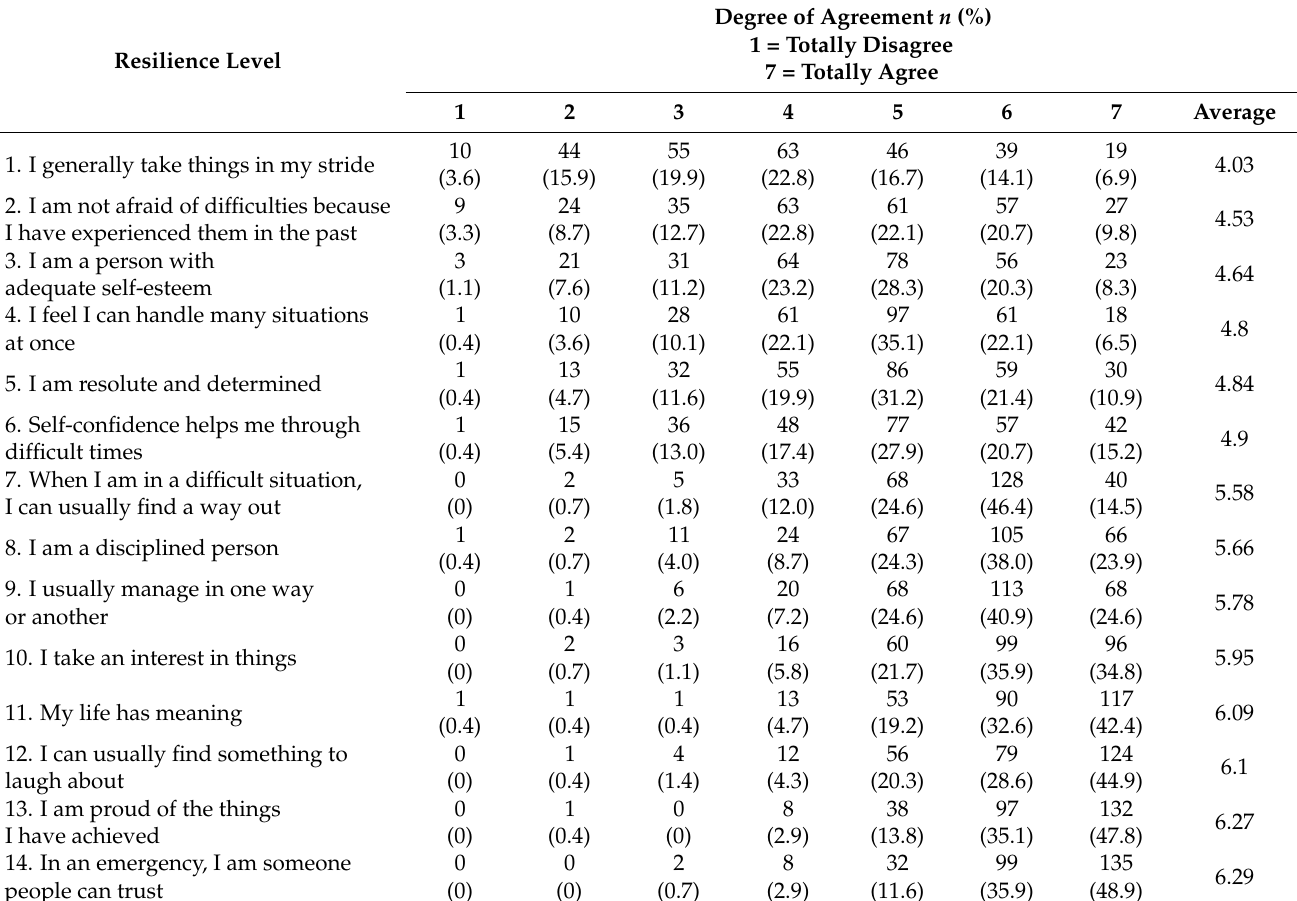
Table 2. Participants’ responses related to resilience